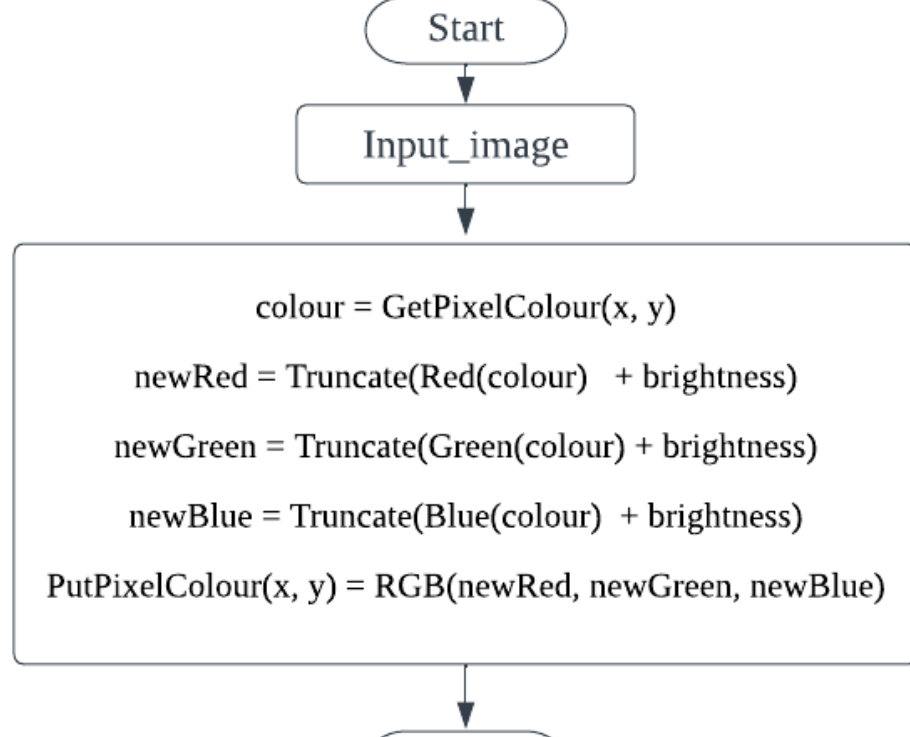
Figure 7. Fire images before and after hue augmentation.